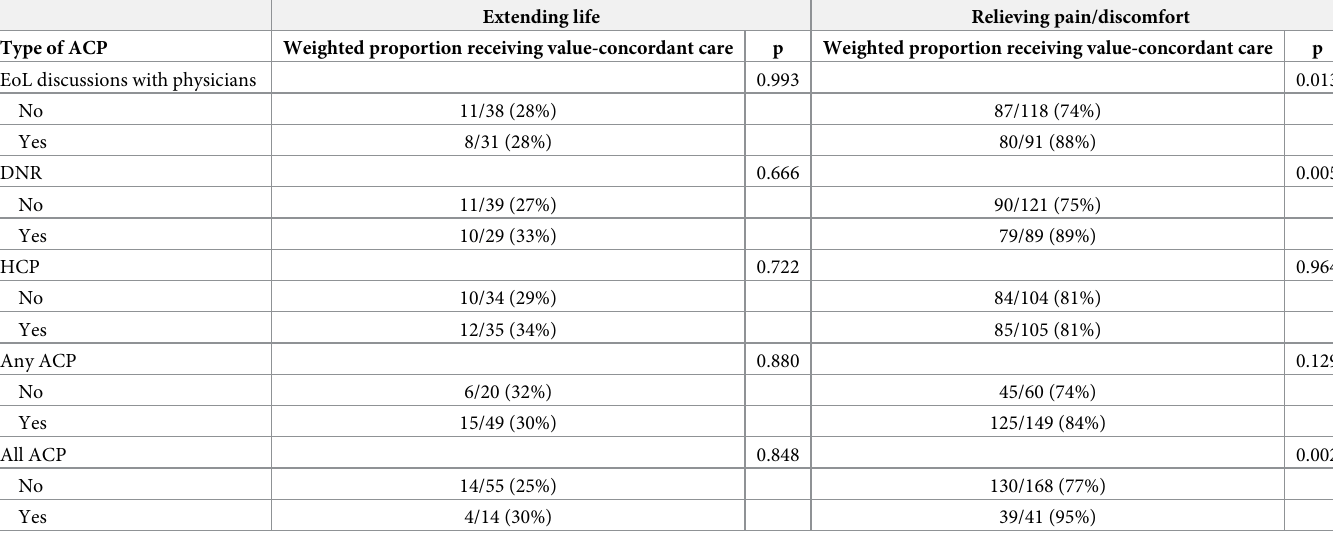
Table 3. Weighted proportion of patients receiving value-concordant care by treatment preference and type of advance care planning (N = 278). Extending